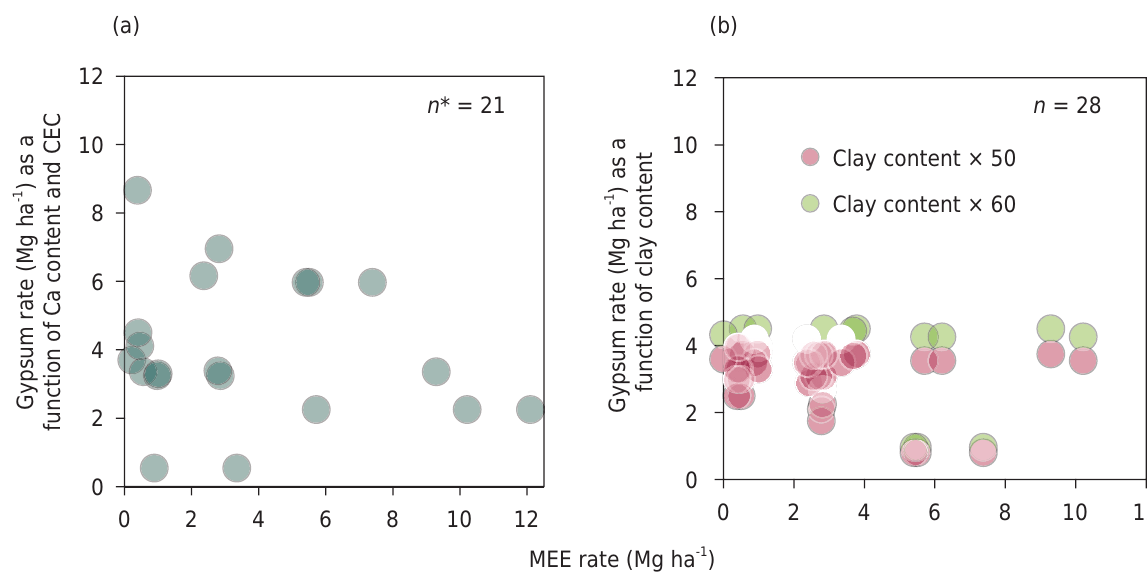
Figure 5. Comparison between the gypsum rate of maximum economic efficiency (MEE) (95 % of yield) obtained in growing seasons with positive response to gypsum application, and gypsum rates calculated according to different recommendations based on soil exchangeable Ca content and CEC (a: Caires and Guimarães, 2016) or on clay contents [b: clay × 50 (Sousa and Lobato, 2004) and clay × 60 (Quaggio and van Raij, 1996)] for subtropical soils under no-tillage in South of Brazil. * : only 21 growing seasons with a positive response were studied (for which Ca contents and CEC of the soil subsurface were